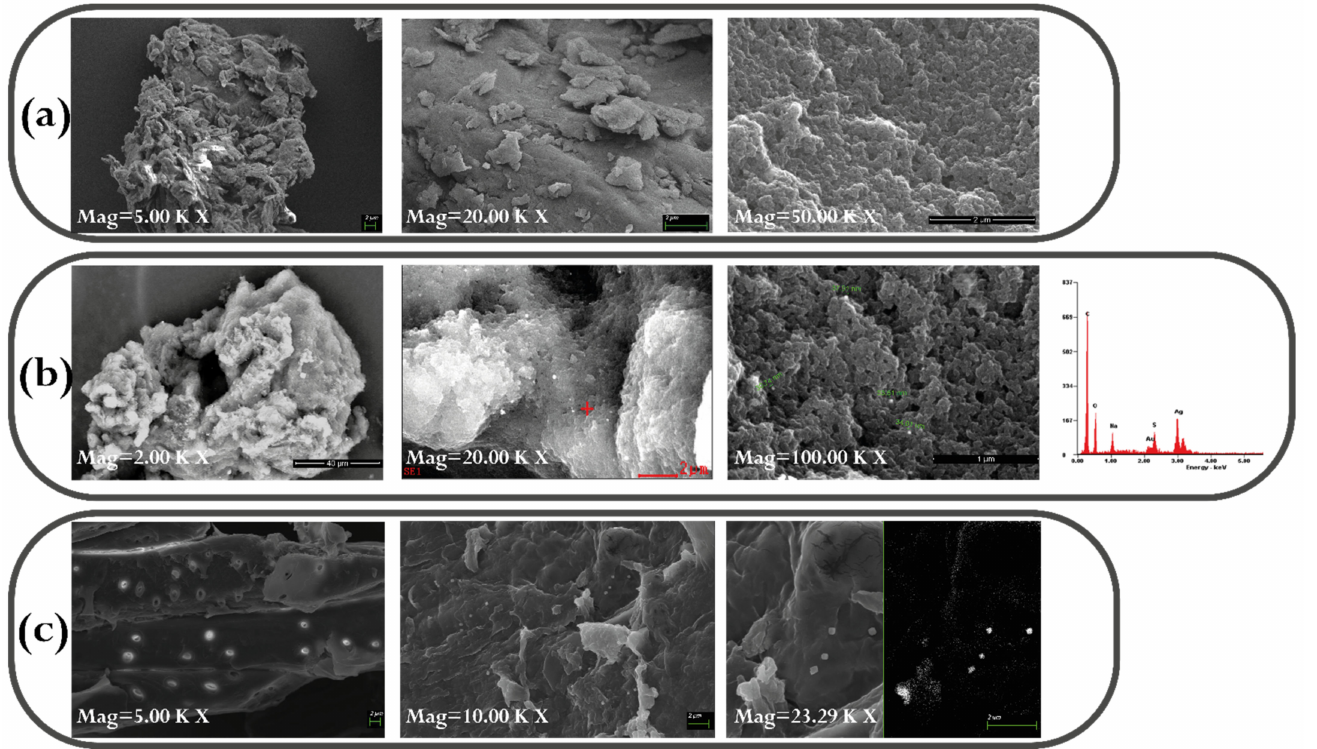
Figure 1. SEM micrographs showing the morphology transformation: ( a ) Coffee husk, ( b ) AgNPs– coffee husk and, ( c ) AgNPs–coffee husk after heavy metal ions’ sorption experiment. EDX analysis of AgNPs-coffee husk (at red + sign) is presented in figure ( b ), which includes Ag peak. FT–IR measurements were used to understand the role of the AgNPs’ modification on the biomass materials. The FT–IR spectra is presented in Figure 2. The peak around 3328 cm − 1 is attributed to the − OH stretching as a result of functional groups of cellulose, hemicellulose, and lignin [44,49]. The peak of 2919 cm − 1 corresponds to C–H groups, 1731 cm − 1 , 1639 cm − 1 C=O of aldehyde and ketone groups, 1458 cm − 1 from aromatic C=C stretching groups and CH 2 and CH 3 groups, around 1371 cm − 1 from aromatic